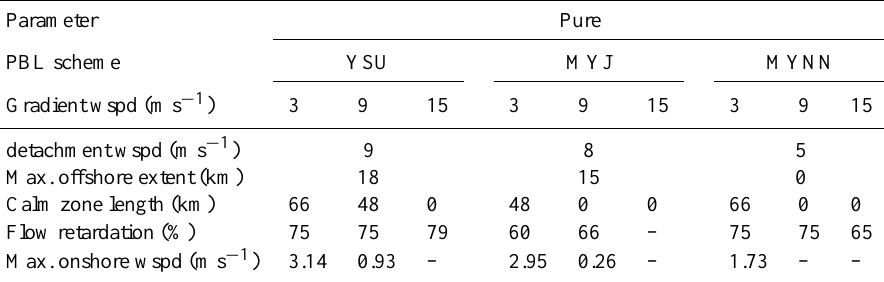
Table 4. Summary of pure sea breeze dual-coast characteristics for varying offshore gradient wind speeds and PBL schemes. The detachment wind speed is the minimum offshore gradient wind speed required to prevent a sea breeze from reaching the coast. The maximum offshore extent is defined as the maximum continuous distance offshore that the u-wind component is less than − 1ms − 1 . The calm zone length is defined as a continuous region with wind speed below 1ms − 1 . The flow retardation percentage is the percentage drop in 10m wind speed over the water surface due to the thermal contrast relative to the average value at 03:00UTC. Supporting figures can be found in the Supplement (Figs.